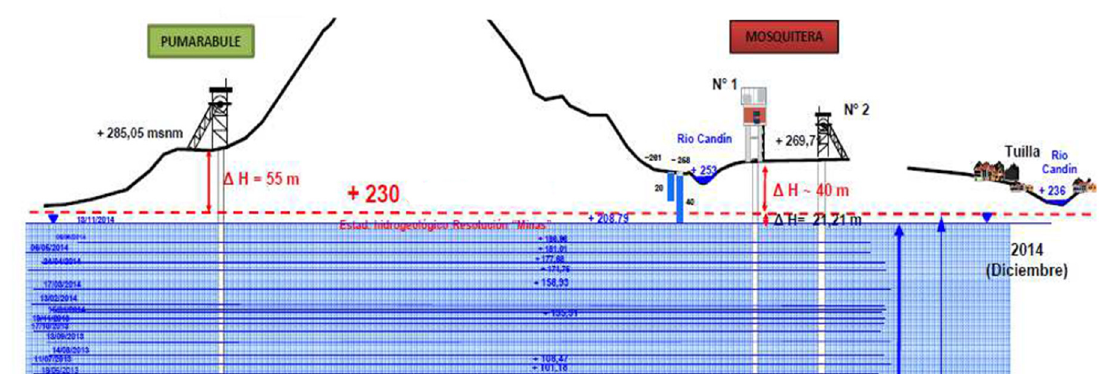
Figure 7. Water rebound monitoring in the Mosquitera and Pumarabule mines (courtesy of HUNOSA). When HUNOSA stopped the pumping in the Mosquitera and Pumarabule mines